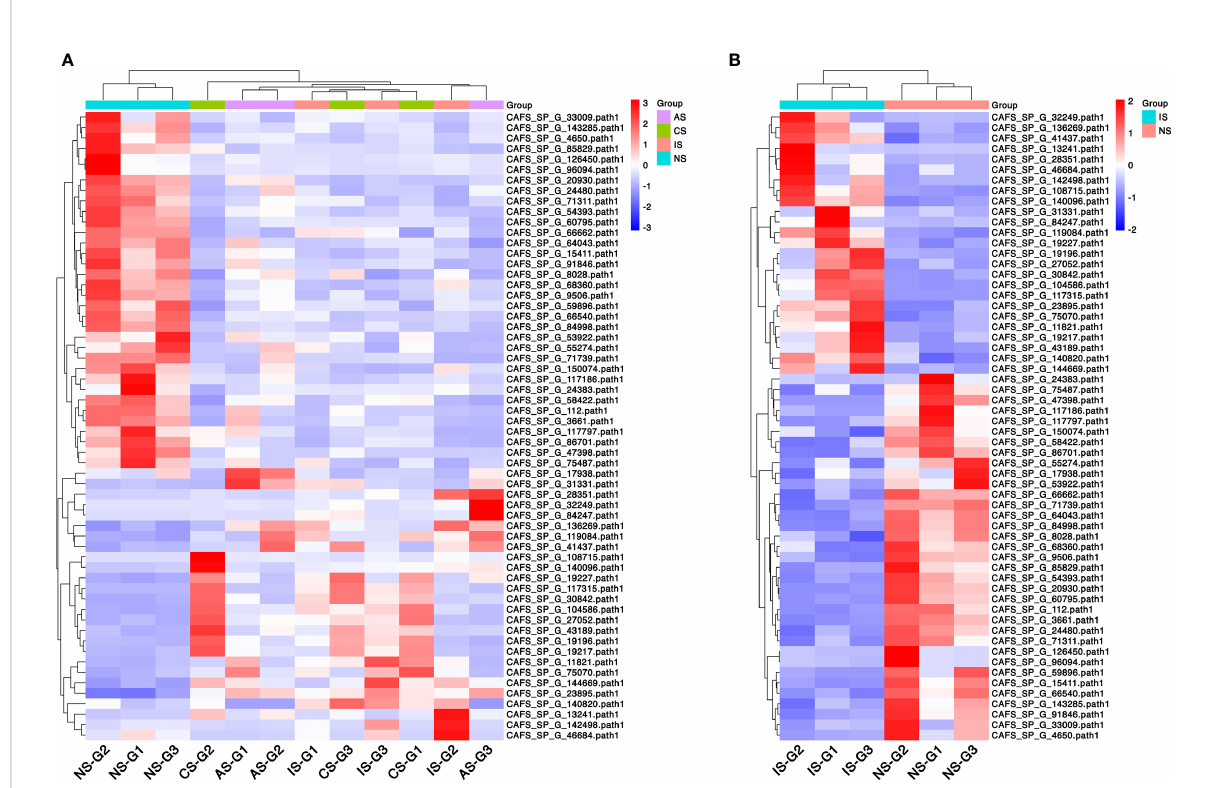
FIGURE 2 Clustered heatmap of common differentially expressed genes (DEGs). (A) Common DEGs expression between the three comparison groups. (B) DEGs expression of IS-vs-NS. Rows represent DEGs and each column represents one sample. The colors represent the expression level, and red and blue indicate higher and lower expression levels,